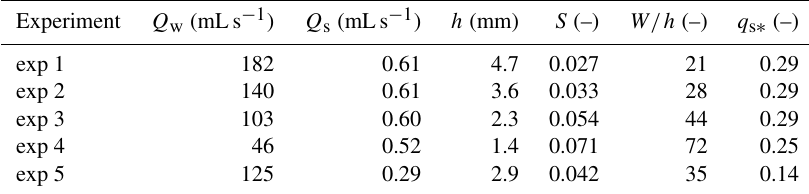
Table 1. Parameter values for each run. The independent variables are water discharge Q w and volumetric sediment flux Q s . Dependent variables are depth h and slope S , measured over the upstream 20cm of scans once the system reached the bypass phase. Aspect ratio W/h and dimensionless sediment flux q s ∗ are also listed, where the dimensionless sediment flux is defined as q s ∗ = Q s d s is the grain size, g is gravitational acceleration, ρ s is the sediment material density, and ρ is the density of